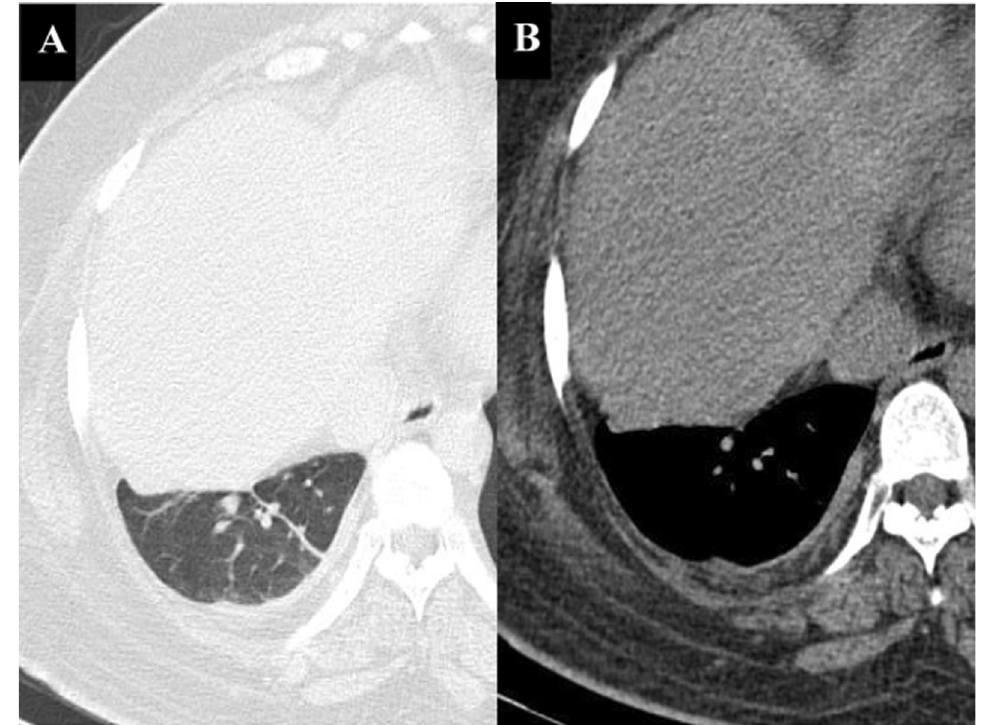
Fig. 5 37‑year‑old male patient with past history of right lower lobe pneumonia 1 month before presented with dyspnea and chest tightness. Axial CT cuts in (A) lung window and (B) mediastinal window showing post‑inflammatory scarring and expansion of the extra‑pleural fat (extra‑pleural fat sign)